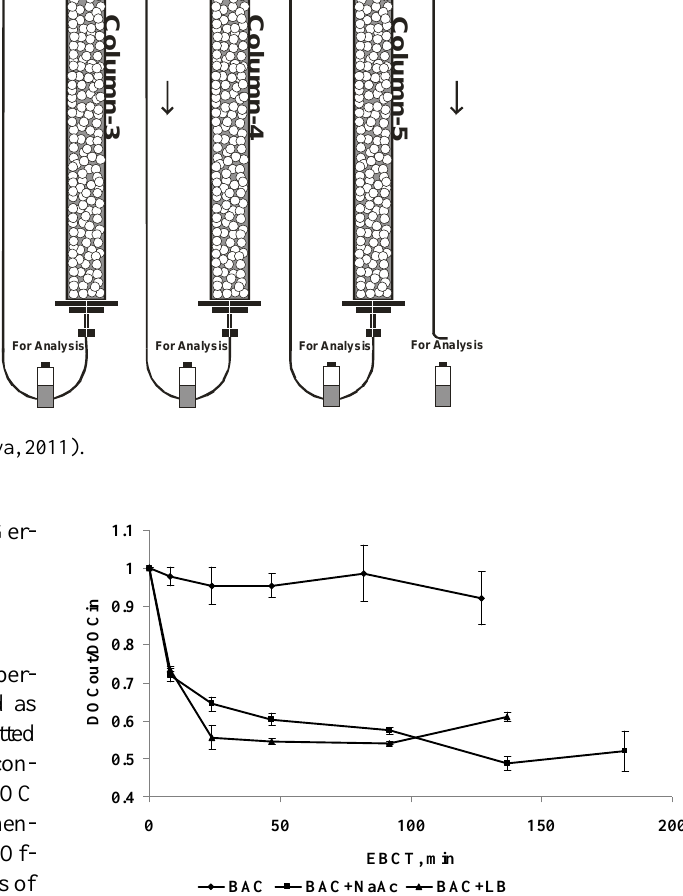
Figure 2. Average DOC changes versus EBCT (adapted from Ti- homirova, 2011). Legends: water sample after biofilters from Dau- gava WTP (BAC, n = 14); water sample after biofilters from Dau- gava WTP with biostimulant sodium acetate after 30h feeding (BAC + NaAc; n = 3) and with Luria Bertrani broth after 48h feed- ing (BAC + LB; n = 3),